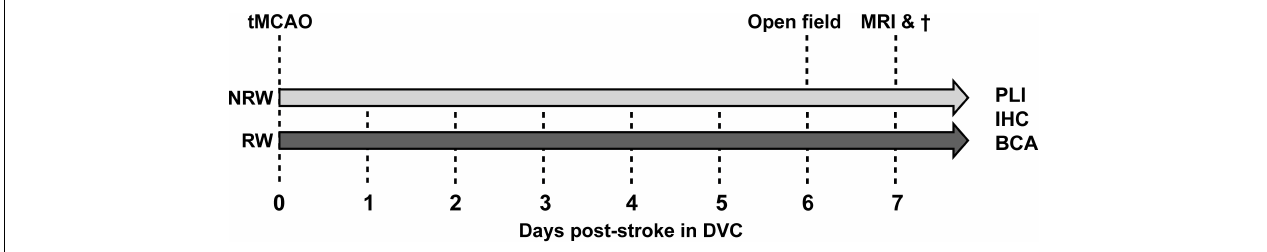
FIGURE 1 | After right transient middle cerebral artery occlusion (tMCAO), mice were randomly allocated into a running wheel (RW) group and a no running wheel (NRW) group. RW mice had 24/7 access to voluntary exercise, while control mice had no running wheel in the cage. Activity/walking patterns of each mouse was individually monitored in digital ventilated cages (DVC) 24/7 for 1 week. Moreover, an open field test was performed to further investigate locomotion and activity. Immediately after MRI scanning, animals were sacrificed and brains were obtained to perform post-mortem immunohistochemistry (IHC), biochemical analysis (BCA), and polarized light imaging (PLI).